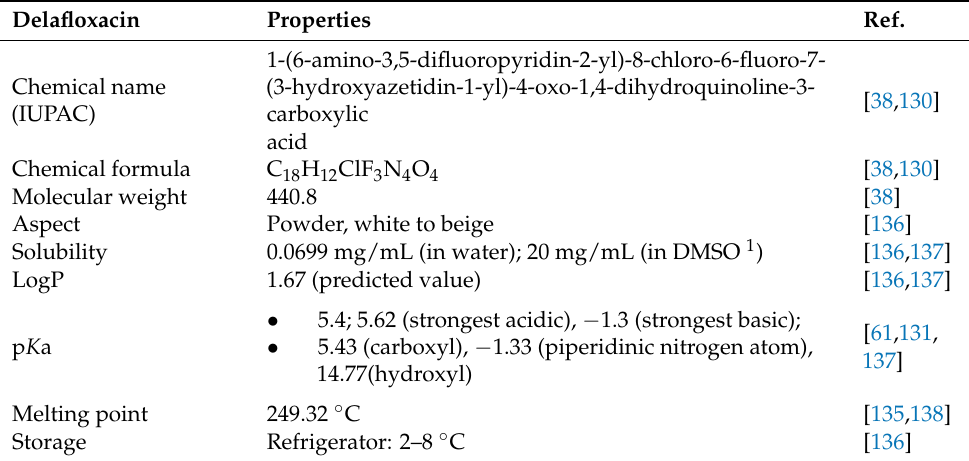
Table 4. Physicochemical properties of